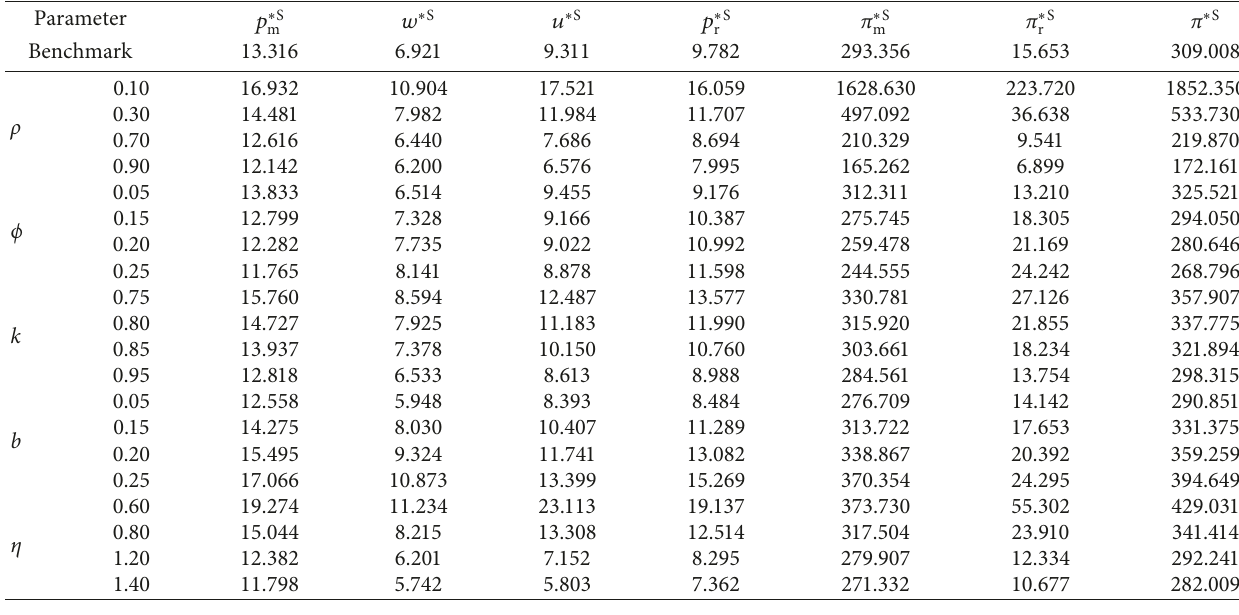
Table 2: Steady-state decisions and profits under static